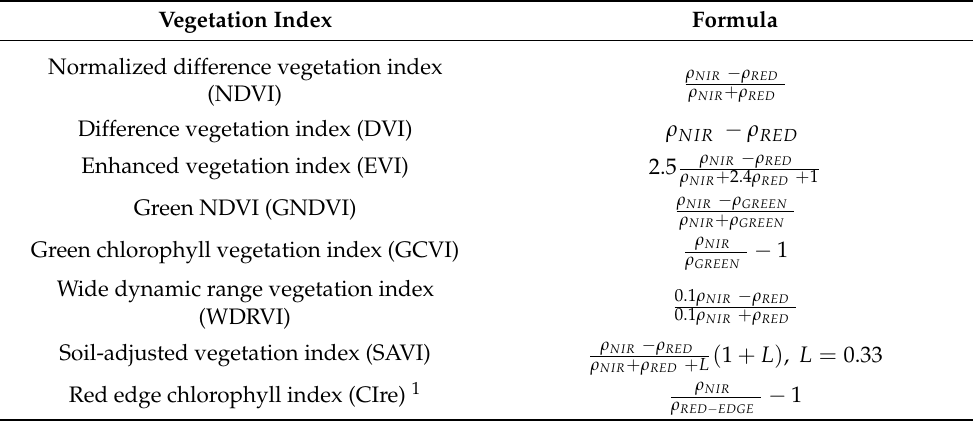
Table 1. Vegetation indices used in the